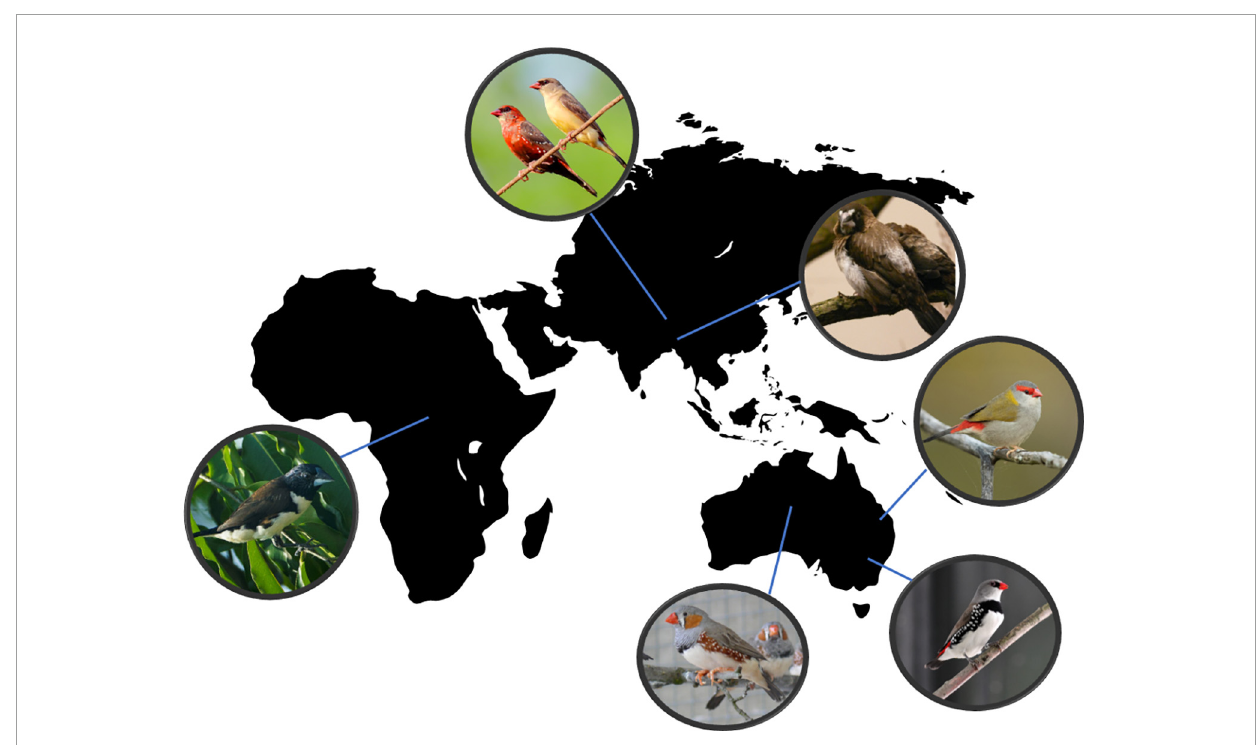
FIGURE1 The three continents, Africa, Asia, and Australia, from where the six examined Estrildid Finch species originated. From left in clockwise direction these species are the Magpie Manikin ( Lonchura fringilloides; photo modified after Francesco Veronesi from Italy, CC BY-SA 2.0, via Wikimedia Commons ); the Red Avadavat ( Amandava amandava; photo modified after Shantanu Kuveskar - Own work, CC BY 4.0, https://commons.wikimedia.org/w/index.php?curid=56884220); the Bengalese Finch ( Lonchura striata var domestica ; photo by ETK); the Red-browed Finch ( Neochmia temporalis; photo modified after JJ Harrison (https://www.jjharrison.com.au/) - Own work, CC BY-SA 4.0, https://commons.wikimedia.org/w/index.php?curid=86319921); the Diamond Firetail ( Stagonopleura guttata; photo by Ulrich Pörschmann), and the Zebra Finch ( Taeniopygia guttata; photo by